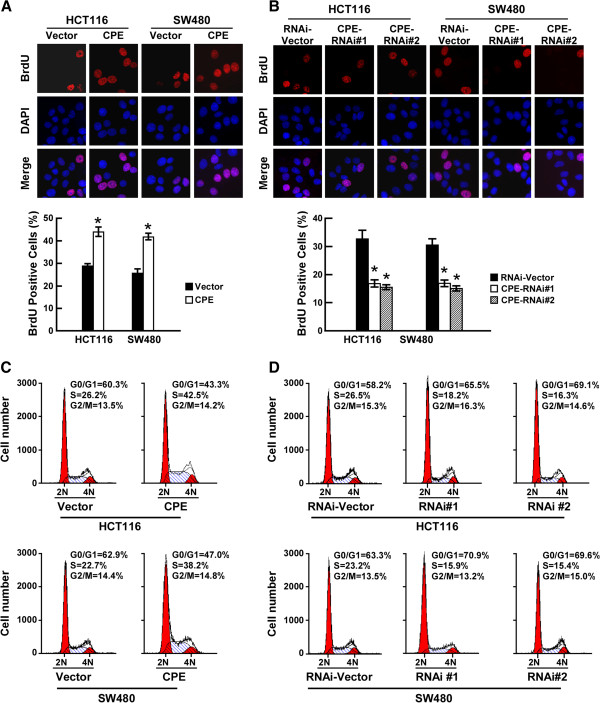
CPE promotes cell proliferation by increasing the S-phase fraction of cells. (A) Representative micrographs (upper panel) and quantification (lower panel) of BrdU incorporation in CPE-overexpressing and vector cells. (B) Representative micrographs (upper panel) and quantification (lower panel) of BrdU incorporation in CPE-silencing and vector cells. (C) Flow cytometric analysis of CPE-overexpressing and vector cells. (D) Flow cytometric analysis of CPE-silencing and vector cells. Data are presented as mean ± SD from three independent experiments. *: P < 0.05.